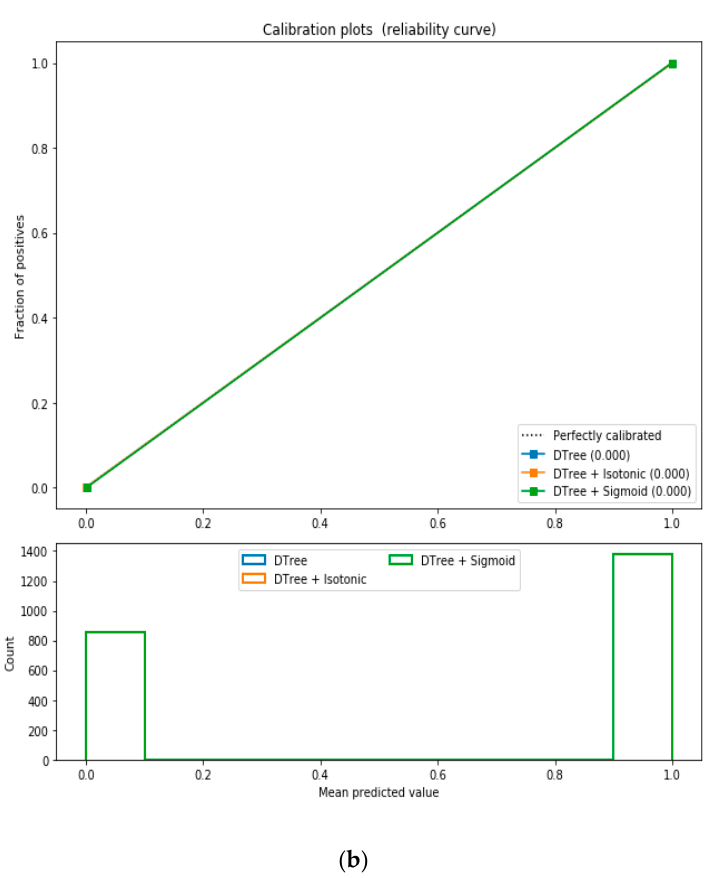
Figure 14. ( a ) Reliability curve to classify the “Eating-health-module” data with different ML classifiers. ( b ) Reliability curve to classify the “Eating-health-module” data with the “Calibrated Decision Tree”.